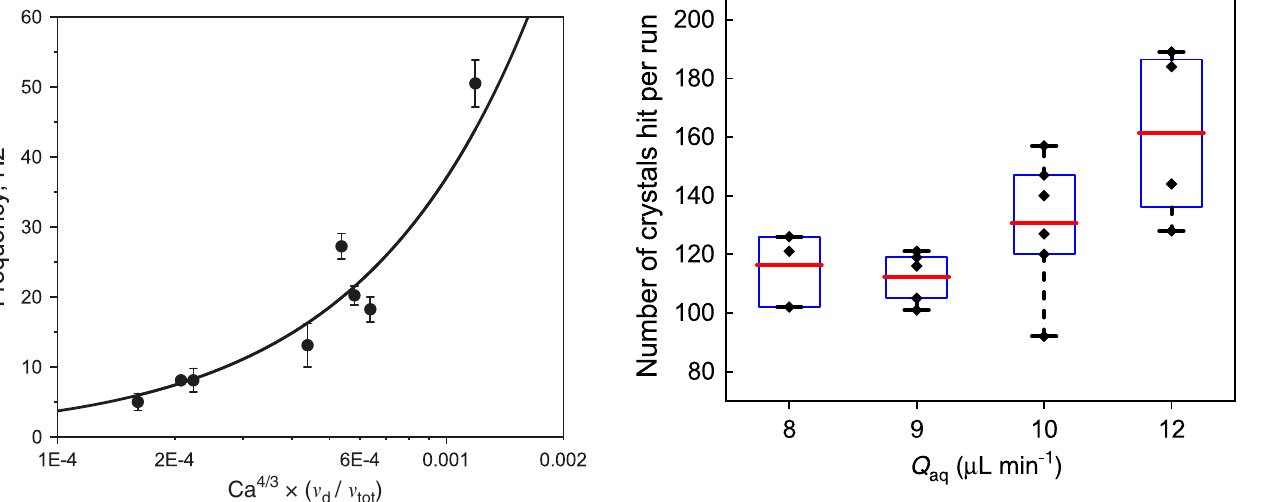
Fig. 3 Comparison of crystals hit per run at different crystal suspension fl ow rates. The oil fl ow rate is fi xed at 15 µ L min − 1 , and crystal suspension fl ow rate is varied. The box plots show the number of crystals hit per run at each condition: rhombs represent hits per individual runs, red lines represent the mean, blue boxes contain 25th to 75th percentile, and whiskers extend to the minimum and maximum values. Source data are provided as a source data fi